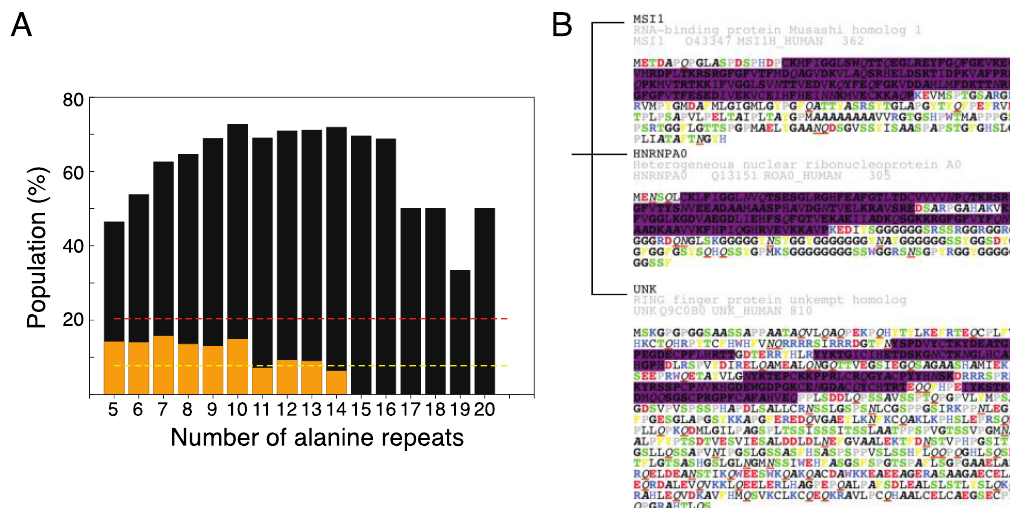
Figure 5. Polyalanine tracts are a common feature of RNA related proteins, and may be one of the ways in which RBPs self-assemble through their IDRs. ( A ) Bioinformatics analysis of the proportions of human proteins with di ff erent lengths of alanine repeats (from 5 to 20) either related to RNA function (black bars; the red dashed line shows the proportion overall) or specifically labeled “RNA binding” (orange bars; overall proportion, yellow dashed line). ( B ) Illustration of the di ff erences in the IDRs of RBPs that bind to similar RNA motifs. The purple shaded regions are those identified by PROSITE as RNA recognition motifs. The amino acids are colored according to their physical properties (positive charge: blue; negative charge: red; F / Y: yellow; W: purple; S / T (potential phosphorylation site for the addition of negative charges): green; P: gray; A: italic-bold black; Q / N: red underlined